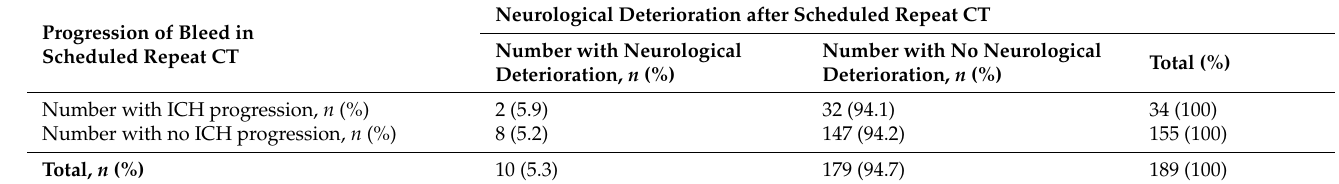
Table 5. Radiological progression of ICH and its relationship with neurological deterioration during admission.